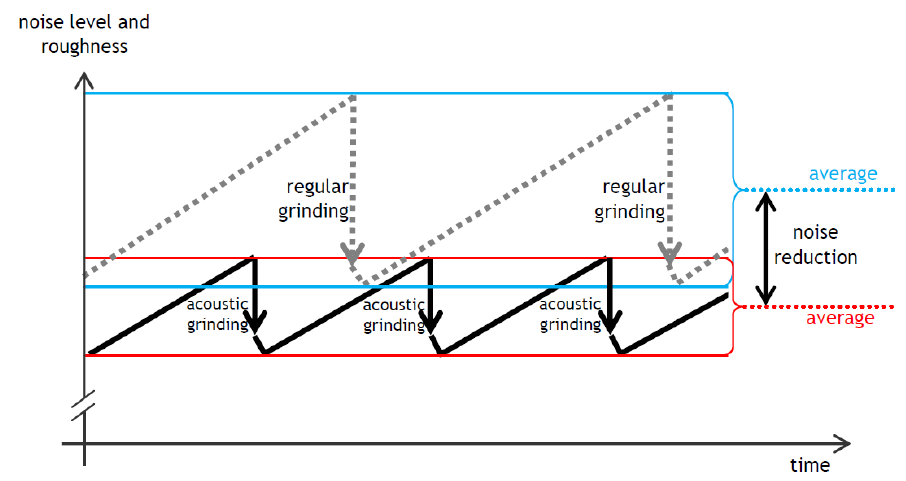
Figure 4. Effects of maintenance grinding and acoustic grinding along time [2].